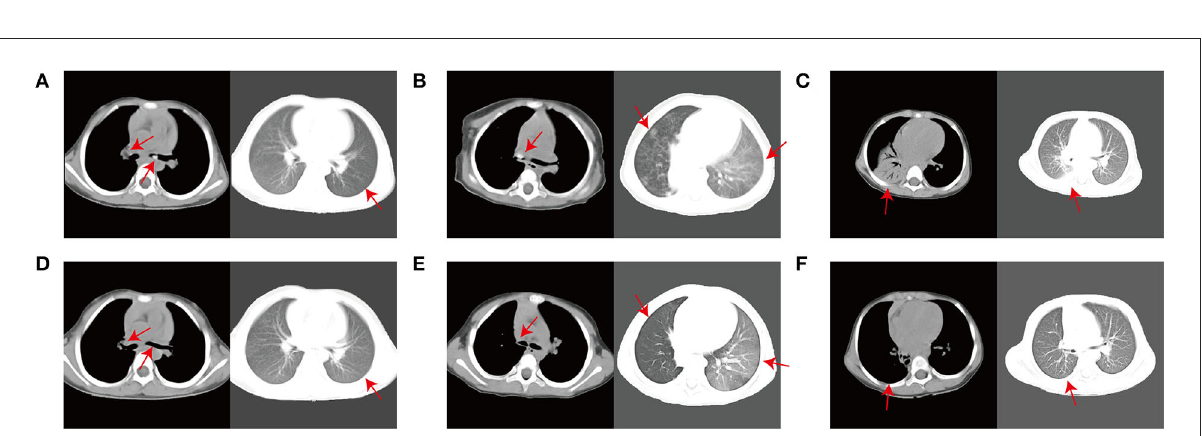
FIGURE2 CT scan findings before interventional therapy and after 3 months of the first interventional therapy. (A) Pulmonary CT results of case 1 suggested a soft tissue density nodule with a dense shadow in the left main bronchus (before treatment). (D) CT scan results after intervention in case 1. (B) Pulmonary CT results of case 2 suggested mediastinal lymph node enlargement with calcification, right middle segment bronchial obstruction and scattered solid lesions in both lungs with corn-like nodular shadow (before treatment). (E) CT scan results after intervention